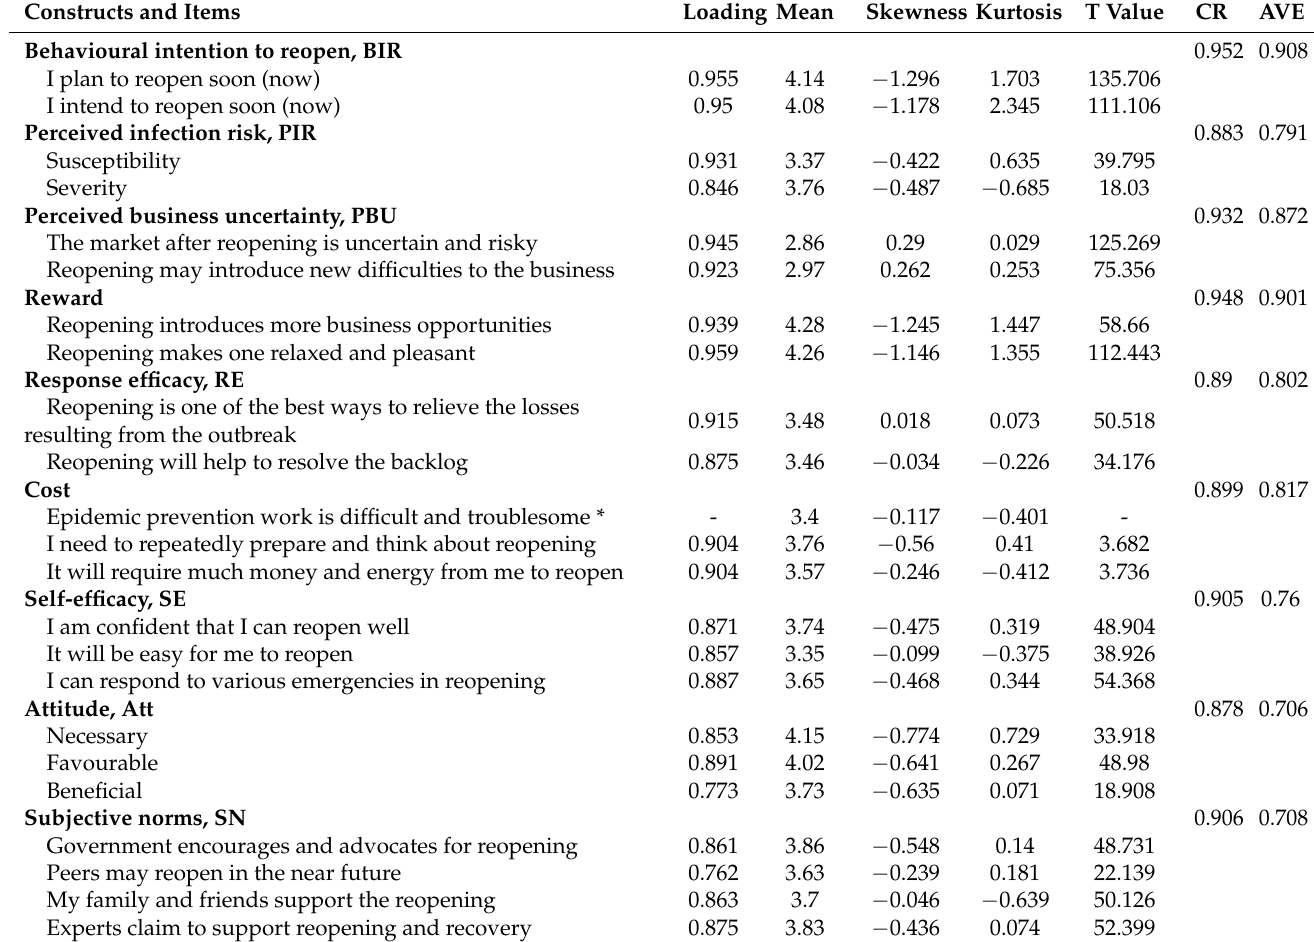
Table 3. First-order measurement model and descriptive